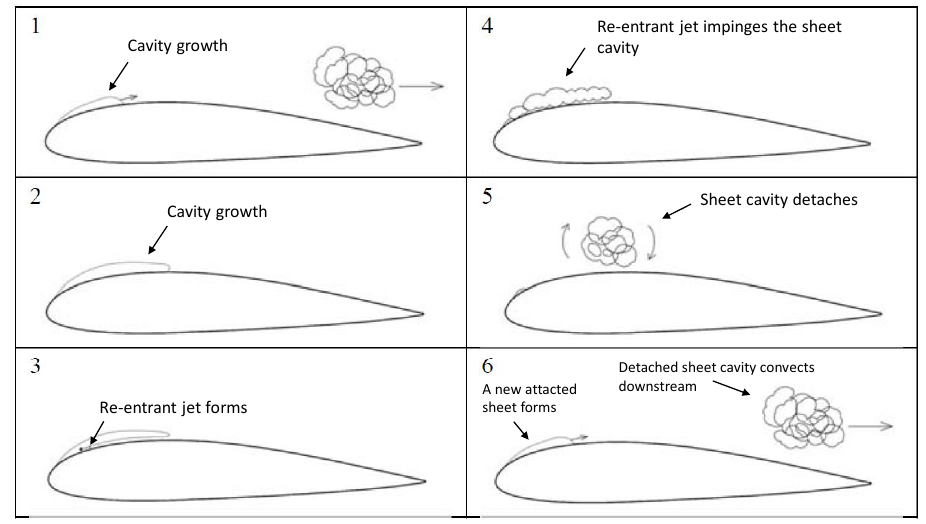
Figure 1. Sketch of the shedding mechanism of sheet cavitation. The figure illustrates one break-off cycle, adapted from